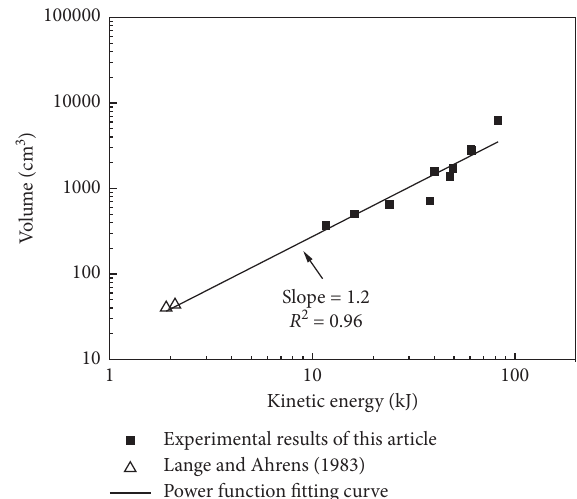
Figure 12: Relation between the kinetic energy of the projectile and the volume of the final crater.